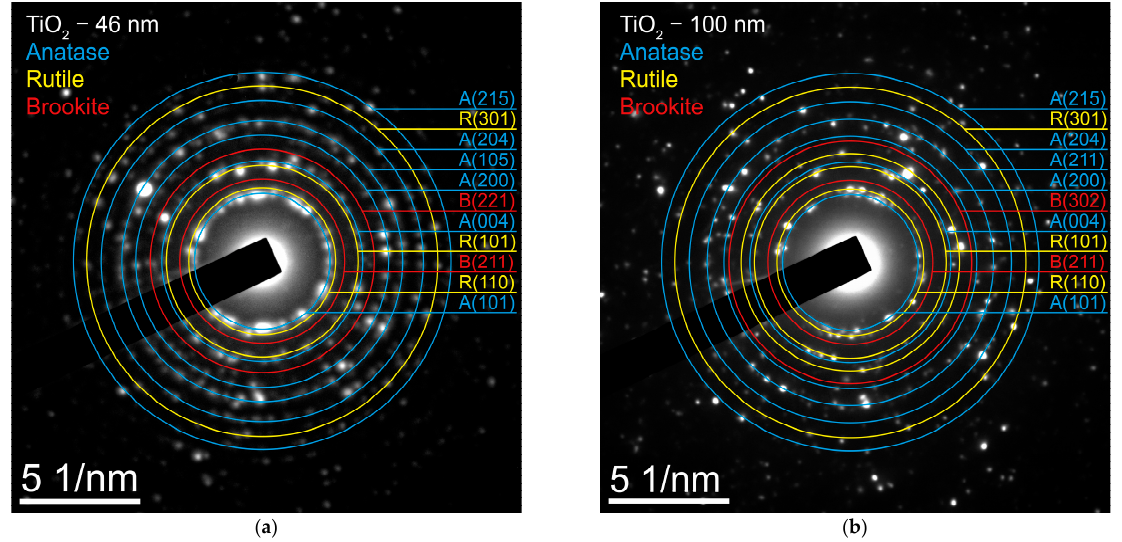
Figure 3. SAED patterns of the as-synthesized TiO 2 samples: d av = 46 nm ( а ), and d av = 100 nm ( b ). The following symbols are used: A—anatase, R—rutile, and B—brucite. The numbers in parentheses correspond to the hkl indices of the atomic planes.